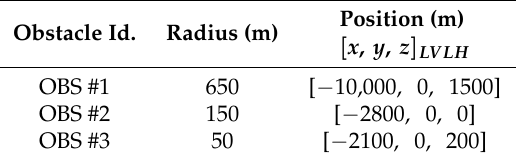
Table 3. Obstacles LVLH